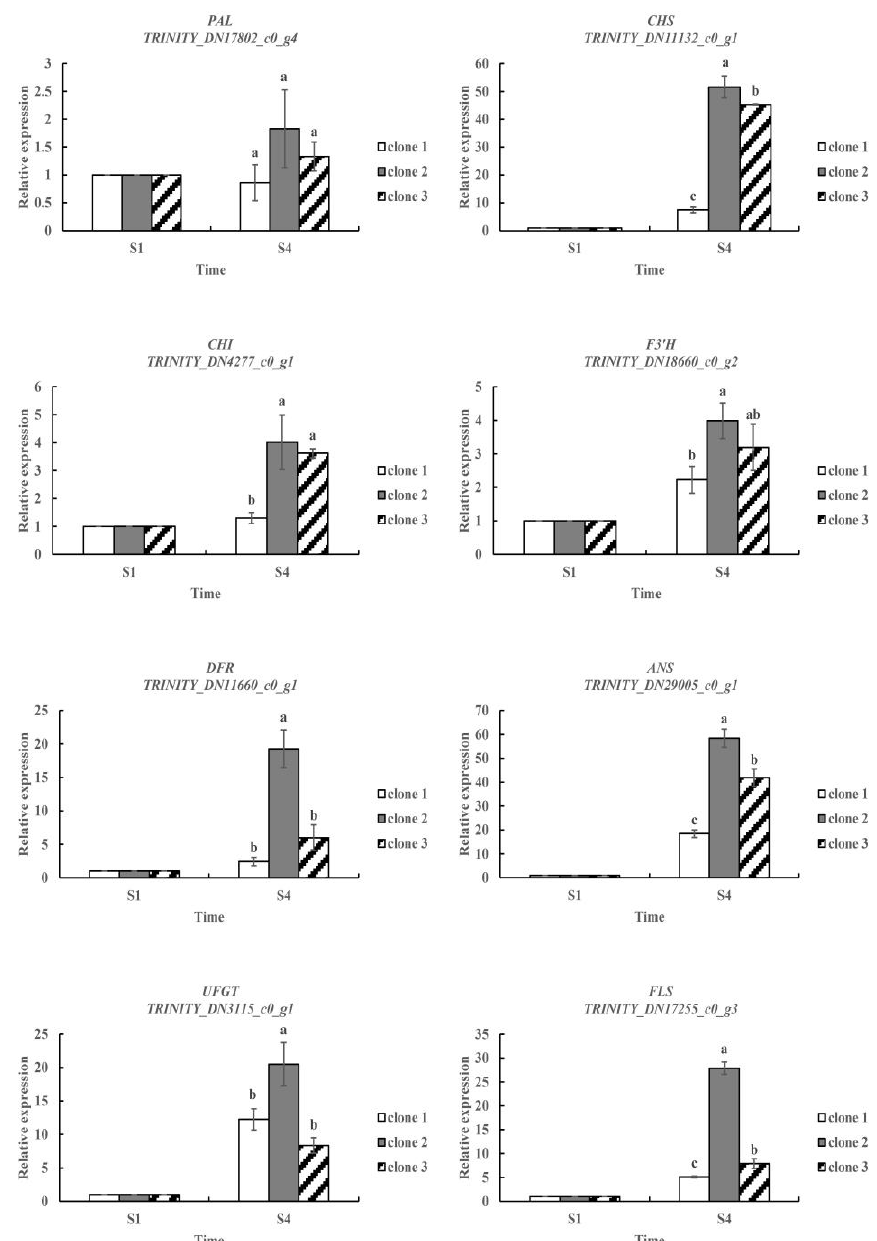
Figure 5. Expression of leaf color-related unigenes of L. formosana quantified by qRT-PCR. Bars with different lowercase letters are significantly different ( p < 0.05). There were three biological replicates in each clone at each stage.